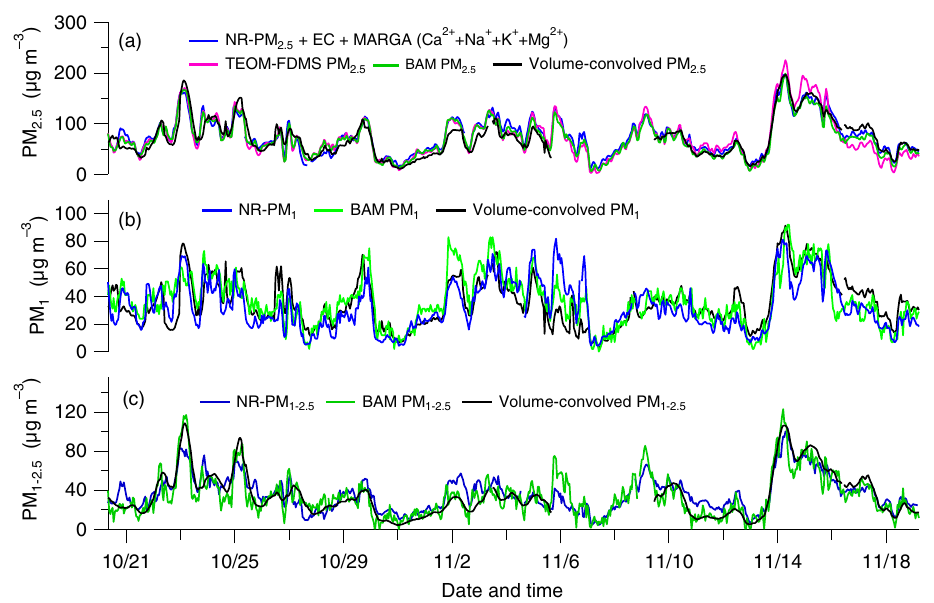
Figure 1. Comparisons between the total particle mass concentrations measured by the PM 1 and PM 2 . 5 ACSMs, a PM 2 . 5 TEOM-FDMS, and two Met One BAM-1020 instruments (for PM 1 and PM 2 . 5 , respectively), as well as volume-convolved mass calculated from the TDMPS and APS, i.e., PM 1 ( ∼ 13–1000nm), PM 1 − 2 . 5 ( ∼ 1000–2500nm), and PM 2 . 5 ( ∼ 13–2500nm), and particle density calculated by the ACSM species. Note that NR-PM 1 and NR-PM 2 . 5 are the mass loadings of the sum of organic, nitrate, sulfate, nitrate, ammonium, and chloride from PM 1 and PM 2 . 5 ACSM, respectively. Dates are indicated in mm/dd